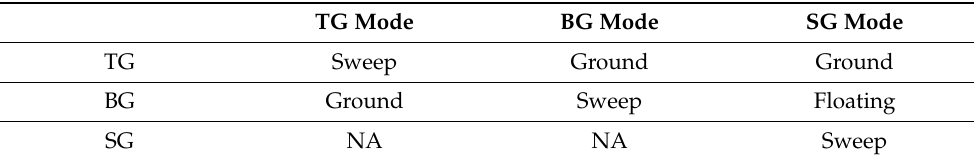
Figure 4. Schematics of the three different sensing modes of the proposed triple-gate a-IGZO TFT-based ISFET sensor platform: ( a ) TG-biasing TG-sensing (TG mode), ( b ) BG-biasing TG-sensing (BG mode), and ( c ) SG-biasing TG-sensing (SG mode). Table 1. Bias conditions for each gate voltage in the three operating modes of the triple-gate a-IGZO TFT-based sensor platform.